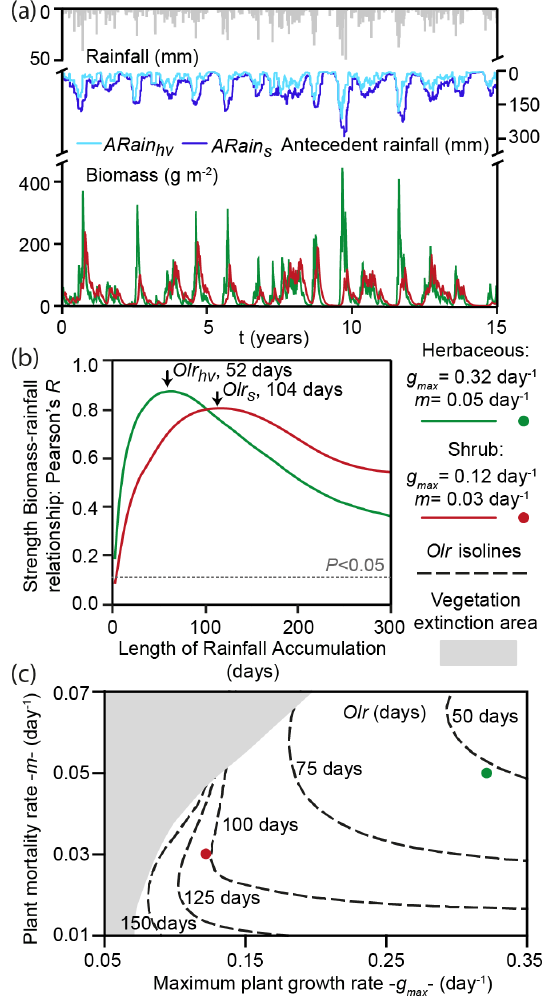
Figure 1. Simulated dryland biomass–rainfall relationships for herbaceous and shrub vegetation: (a) modelled biomass dynamics for a herbaceous (green) and a shrub (red) species, (b) strength of the biomass–precipitation relationship (Pearson’s R correlation) using different lengths of rainfall accumulation for the simulated herbaceous and shrub species (values above the dotted grey line are significant at P < 0 . 05), and (c) optimal rainfall accumulation length ( Olr ) as a function of the plant-growth and mortality rates. ARain hv and ARain s lines in panel (a) represent the antecedent rainfall series that best correlate with the simulated series of herba- ceous and shrub biomass, respectively (i.e. time series of prece- dent rainfall with rainfall accumulation lengths Olr hv for herba- ceous vegetation and Olr s for shrubs). The green and red dots in panel (c) indicate optimal rainfall accumulation lengths obtained for the simulated herbaceous ( Olr hv , 52 days) and shrub ( Olr s , 104 days) species, respectively. The (grey) “vegetation extinction” area in panel (c) reflects combined values of plant-growth and mortal- ity rates that do not support long-term vegetation dynamics for the simulated rainfall